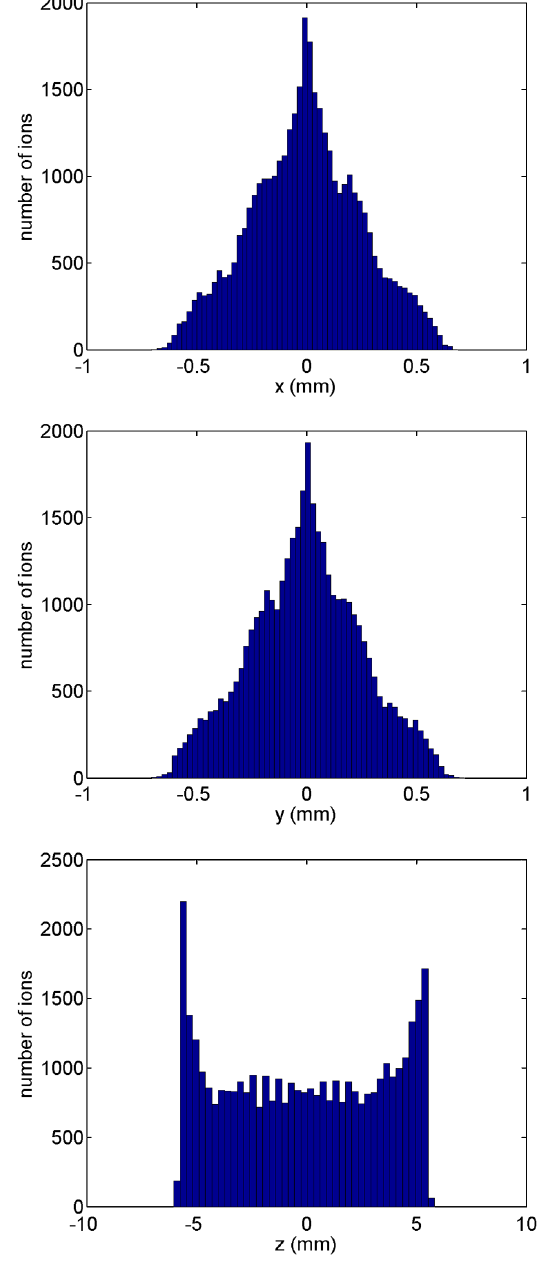
FIG. 1. Distribution of H þ 2 ions after 10,000 interactions with a 100 MeV